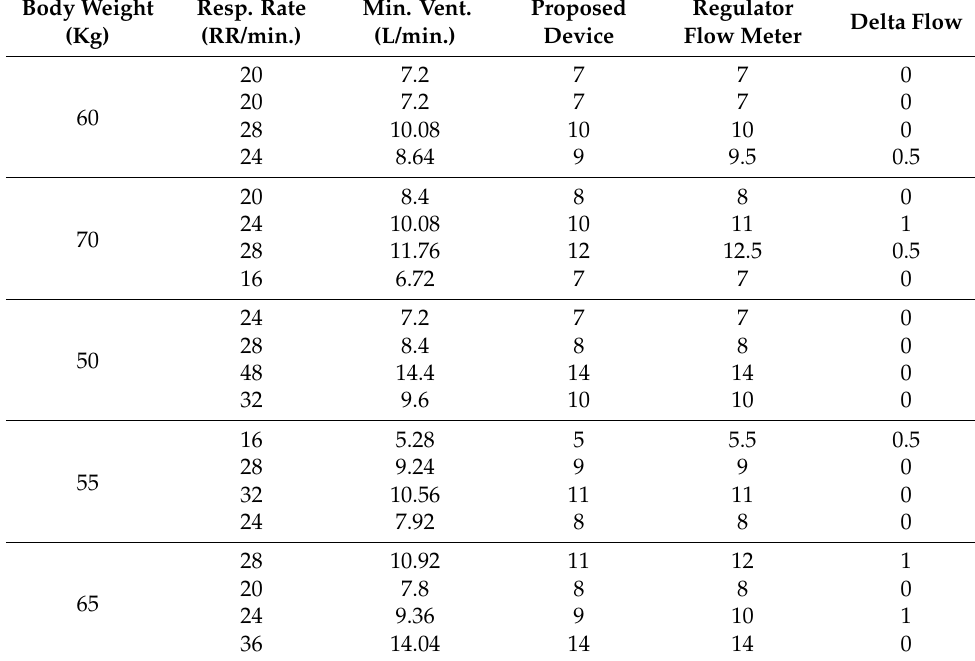
Table 7. The test results of the proposed system in the control of the regulator in automatic mode. Body Weight Resp. Rate Min. Vent. (Kg) (RR/min.)